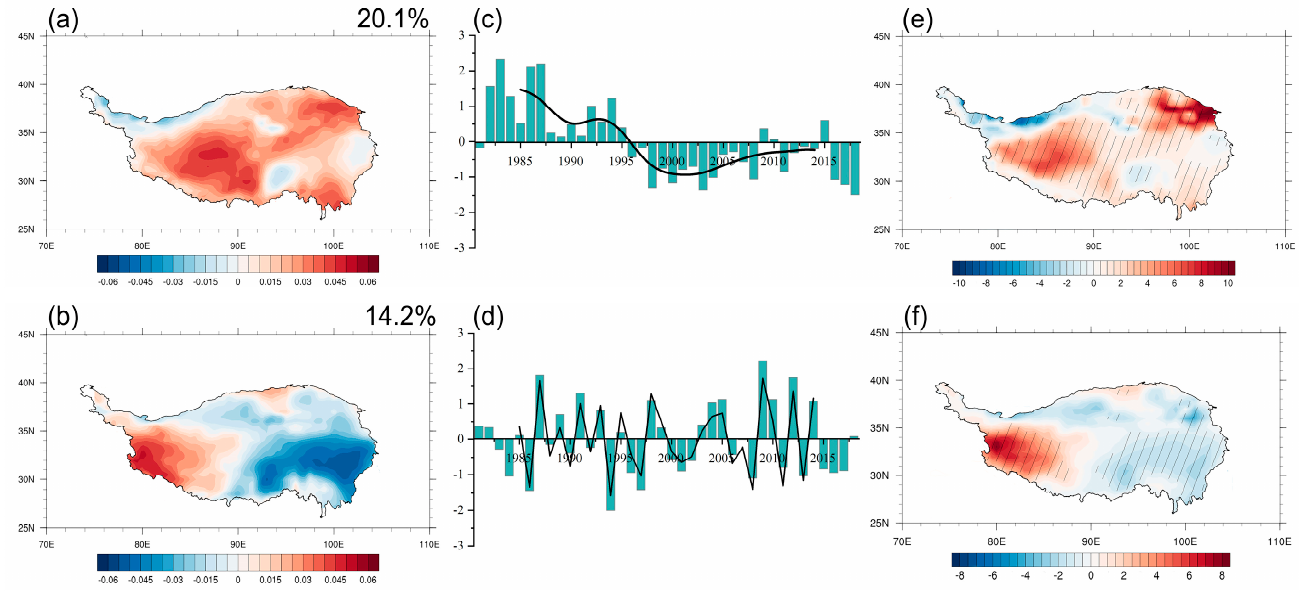
Figure 2. The first two EOFs of summer SH over the TP for the period 1981–2018 ( a , b ). The explained variance of EOF is in the upper right of ( a , b ). Normalized time series of PC1 (column) and its interdecadal component (PC1-ID) (line) ( c ). Normalized time series of PC2 (column) and its interannual component (PC2-IA) (line) ( d ). Regression of the interdecadal component of summer SH (shading, W m − 2 ) on PC1-ID ( e ). Regression of the interannual component of summer SH (shading, W m − 2 ) on PC2-IA ( f ). Grid points with statistically significant anomalies passing the 95% confidence level are denoted by an oblique